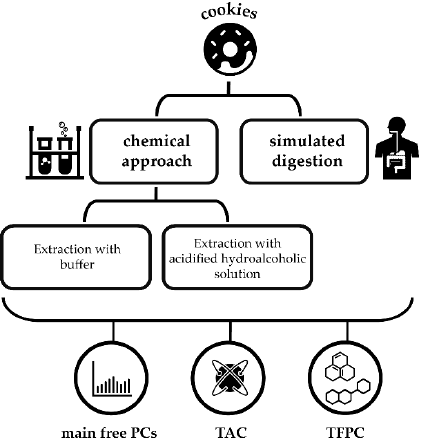
Figure 1. Schematic representation of the approaches used to estimate the (poly)phenolic profile (as main free PCs), the antioxidant capacity (TAC), and the total free PC content (TFPC) of the WG cookies.